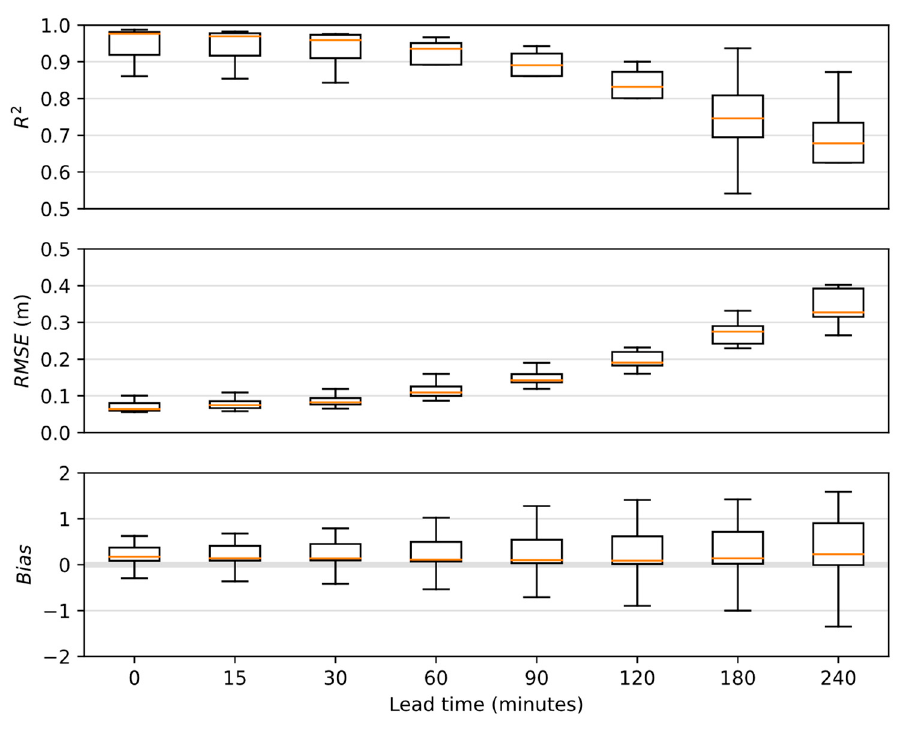
Figure 8. Overall performance of the hybrid model for the test dataset. Values were calculated for each event independently.